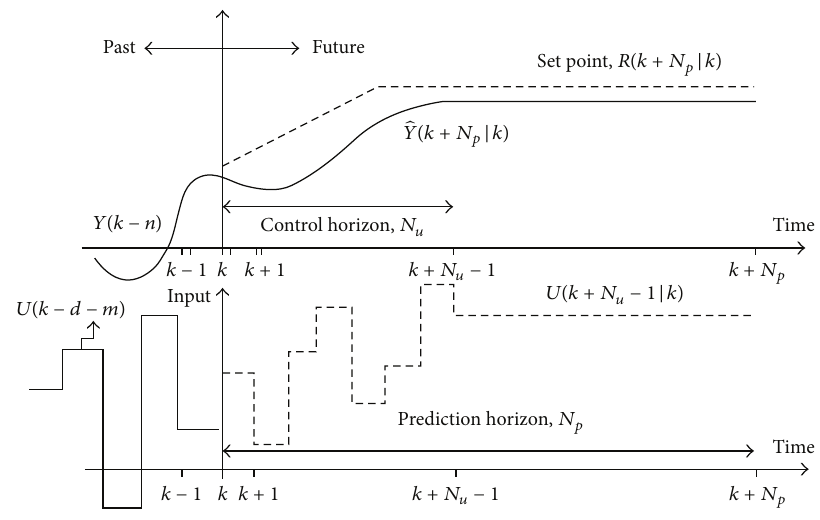
Figure 5: Predictive control: the basic